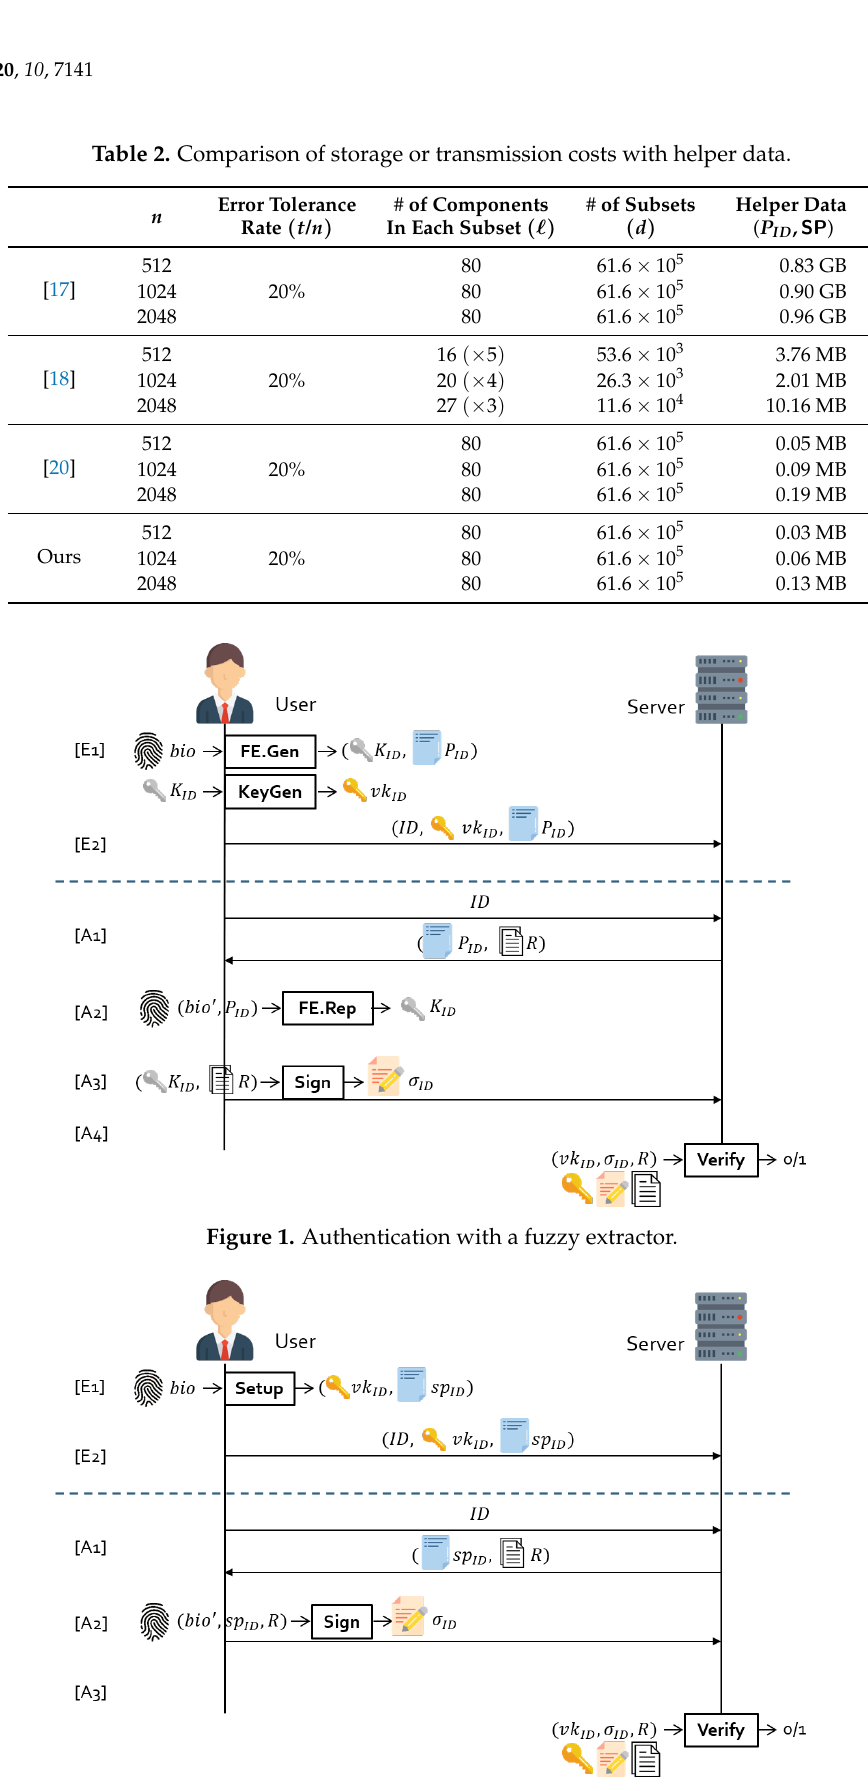
Figure 2. Authentication with our fuzzy vector signature